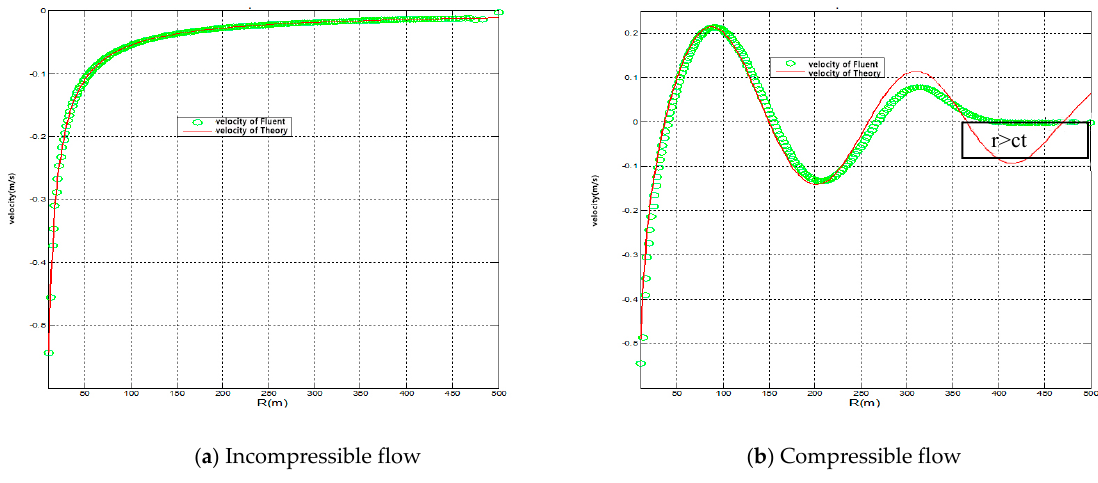
Figure 3. Validation of the velocity vs. radius when t = 1.0 s.